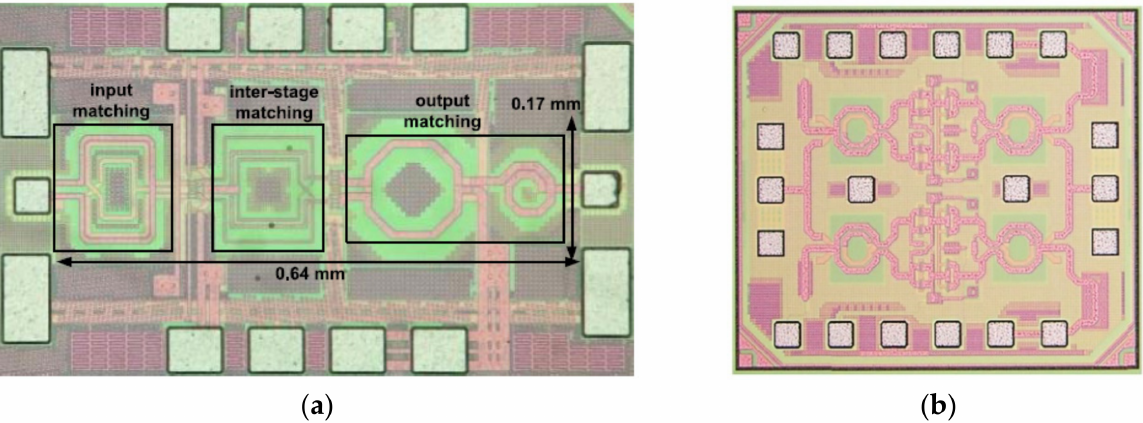
Figure 21. ( a ) The 2-stage CS differential PA in 60 nm CMOS [88] ( b ) 2-stage cascode differential PA in 60 nm CMOS